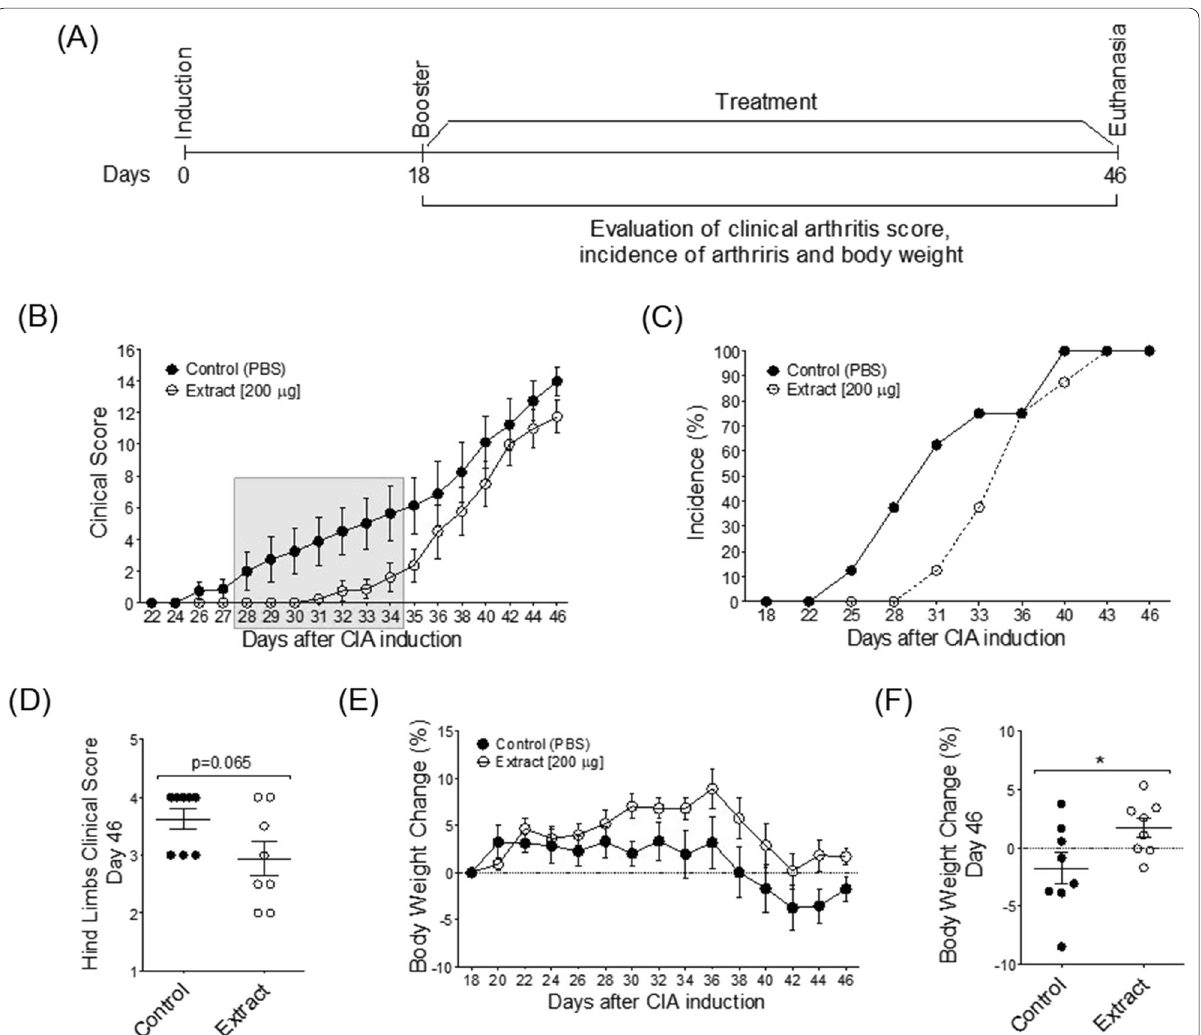
Fig. 6 F. hepatica delayed the beginning of clinical signs of arthritis and prevented body weight loss in CIA. A Illustration of experimental design B Clinical score of arthritis during CIA development C Incidence of arthritis D Clinical score of arthritis in the hind limbs at the last day of the